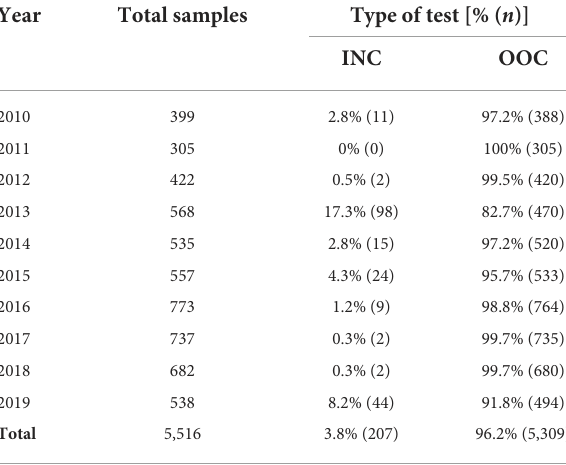
TABLE 5 Annually collected hematological ABP samples by test